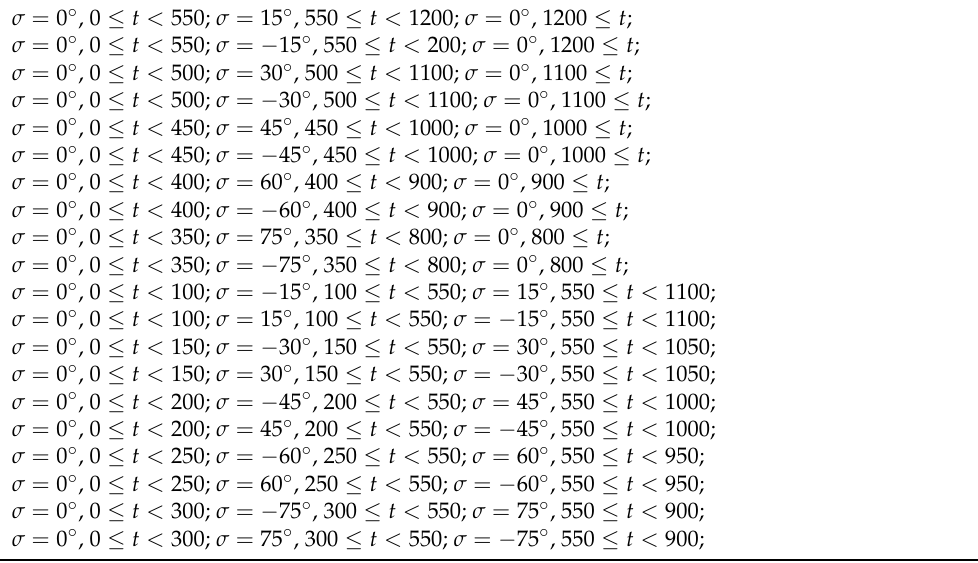
In Table A4, HGVs adjust σ at a fixed time period. t is the flight time of HGVs. Table A4. Lateral maneuver parameters.